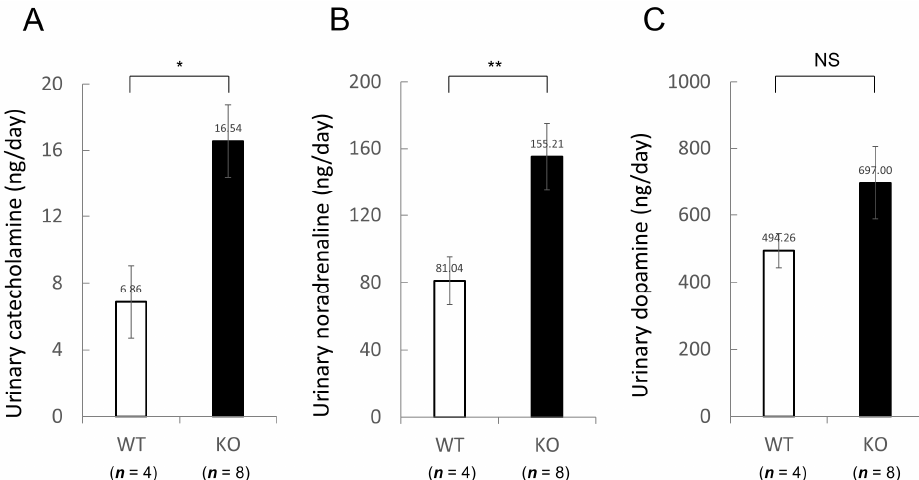
Figure 6. Increased daily urinary catecholamine excretion in Nedd4L C2-knockout (KO) mice. Daily urinary ( A ) catecholamine, ( B ) noradrenaline, and ( C ) dopamine excretion in wild-type (WT) and Nedd4L C2 KO mice. Male wild-type littermates ( n = 4; 8–9 weeks old) and Nedd4-2 C2 − / − mice ( n = 8; 8 weeks old) were used for this experiment. Data are expressed as means ± SE. Statistical analyses were performed by unpaired, two-tailed Student t test. * p = 0.0191, ** p = 0.0329, NS; not significant. Table 4. Serum markers in wild-type and Nedd4L C2-knockout mice. Male wild-type littermates ( n = 8; 7–10 weeks old) and Nedd4-2 C2 − / − mice ( n = 9; 7–9 weeks old) were used for this experiment. Data are expressed as means ± SE. Cr, creatinine; Na, sodium; Ca, calcium. Wild-Type Serum Markers Serum